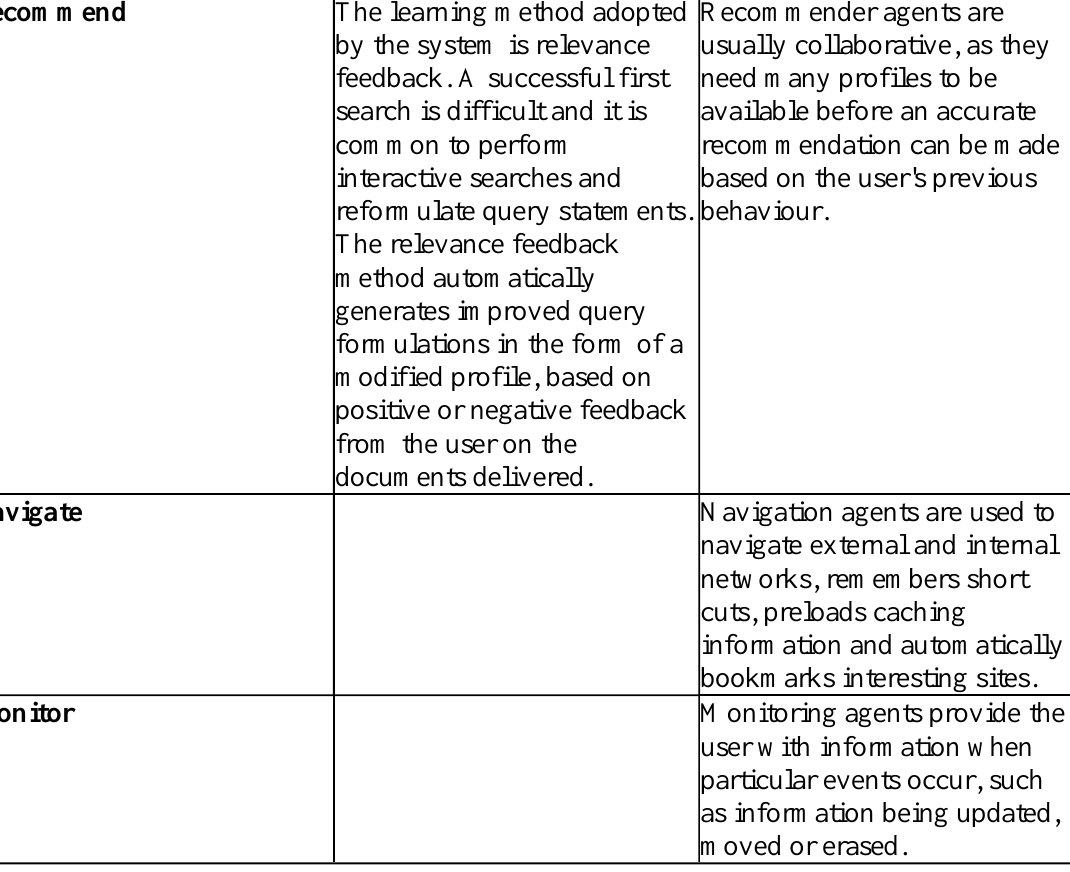
4 Criteria for intelligent agent Web search